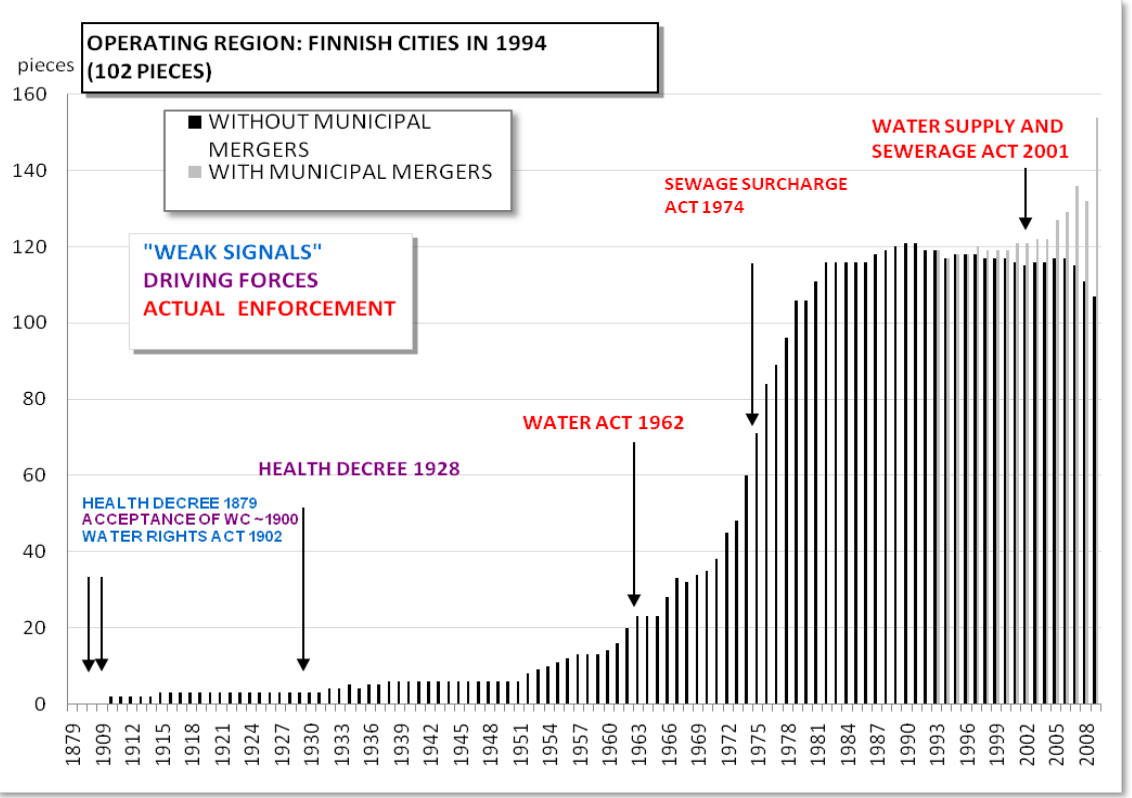
Figure 4. Number of wastewater treatment plants in Finland in 1910–2009 [4].